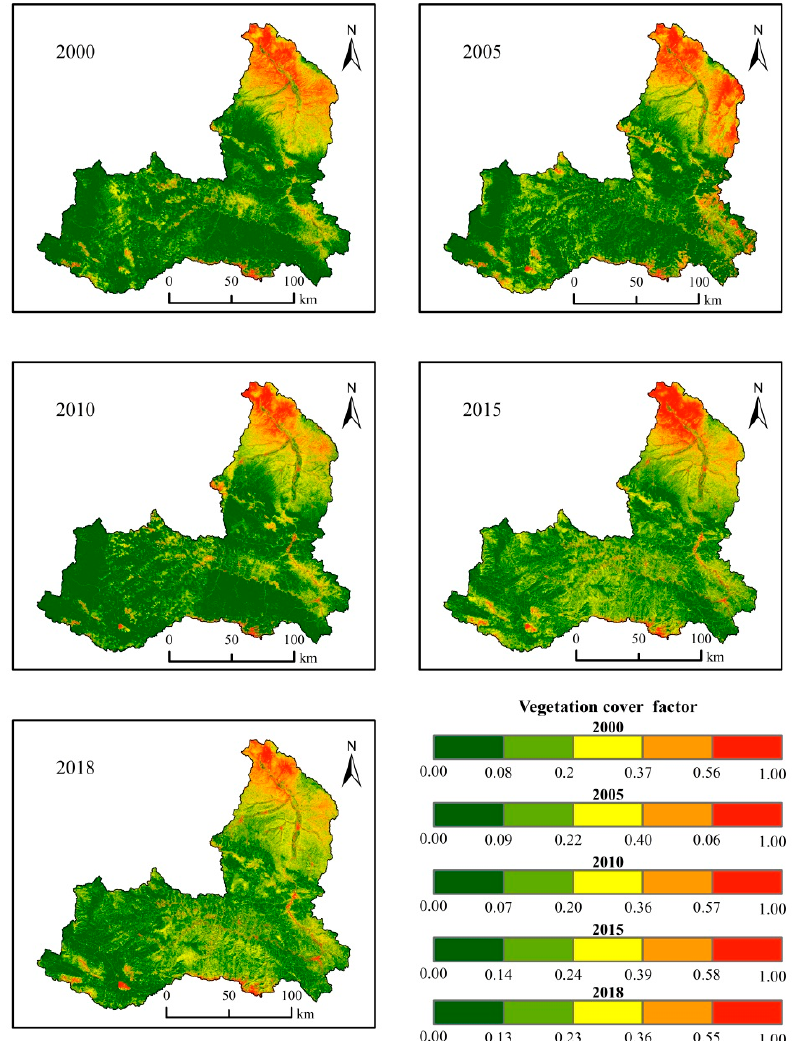
Figure 4. Spatial distribution of vegetation cover factor in the Taohe River Basin in 2000, 2005, 2010, 2015 and